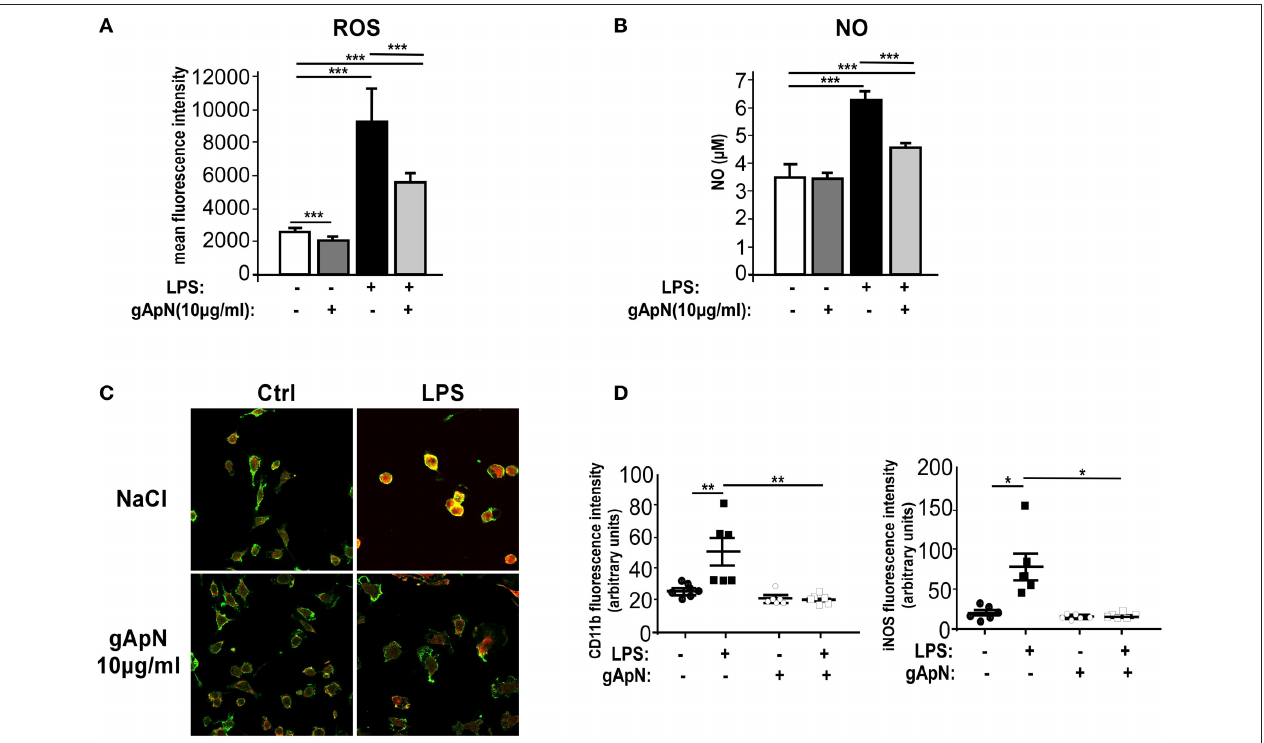
FIGURE 5 | Globular adiponectin limits LPS-induced oxidative and nitrosative stress induction. BV2 cells were pre-treated for 1h with saline (white and black bars) or gApN (gray bars) before addition of saline (white and dark gray bars) or LPS (black and light gray bars) for 3 (C,D) or 15h (A,B) . Reactive oxygen species (ROS) (A) and nitric oxide (NO) (B) were quantified by flow cytometry and Griess reagent assay, respectively, as described in the Materials and Methods section. N group; Kruskal-Wallis test followed by the Iman-Conover method for multiple comparison between groups was performed, *** p < 0.005. (C) Representative images of CD11b (green fluorescence) and iNOS (red fluorescence) immunoreactive BV2 cells pre-treated with saline (upper panels) or gApN (lower panels) and treated with saline (left panels) or LPS (right panels). (D) Quantification of CD11b and iNOS staining using fluorescence intensity values to quantify their respective expression level. N 6 per group, Kruskal–Wallis test followed by the Iman-Conover method for multiple comparison between groups was performed, * p < 0.05, ** p < =